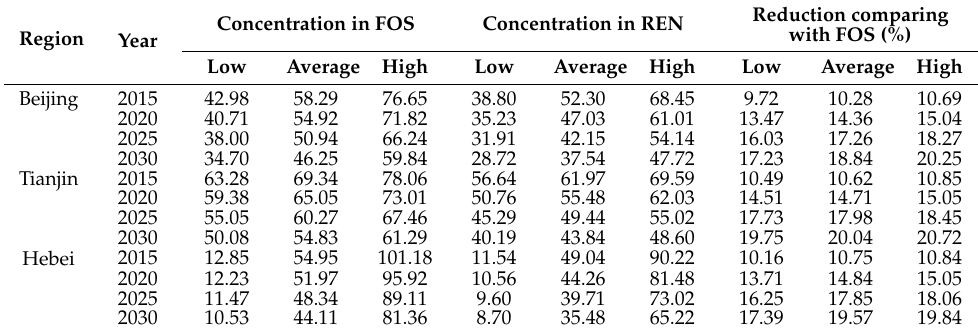
Table 5. Annual average PM 2.5 concentration ( µ g/m 3 ) 1 .